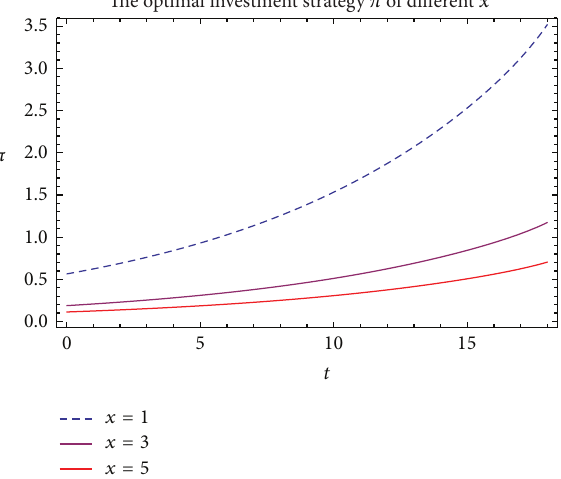
Figure 1: Evolutions of optimal investment strategy 𝜋 ∗ with differ- ent risk aversion coefficients 𝛾 .